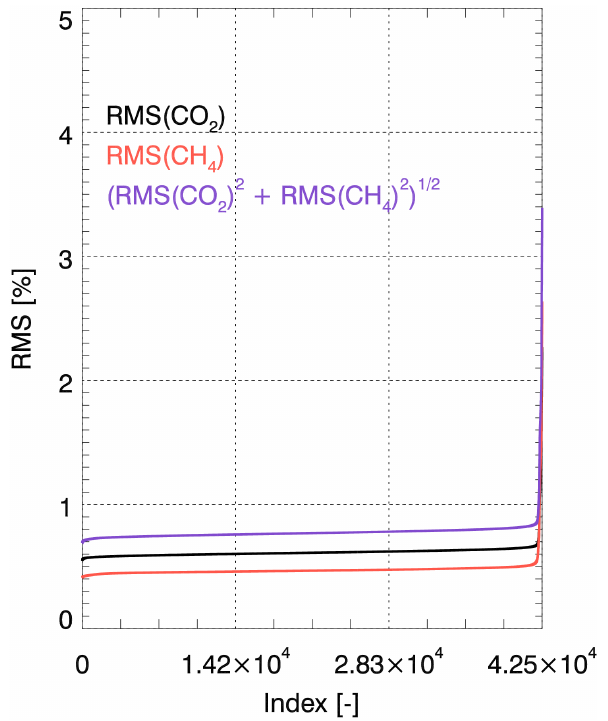
Fig. 2. Fit quality of the measurements ordered by the root-mean- square value of the relative differences between measurement and model after the